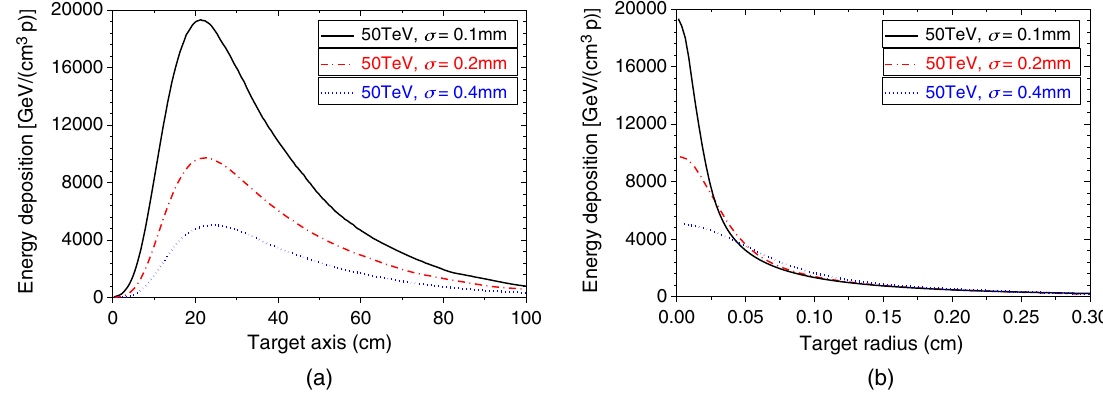
FIG. 4. Energy deposition per 50 TeV proton in a cylindrical copper target for three different beam sizes (a) in the longitudinal direction at r ¼ 0 and (b) in the radial direction at L ¼ 21 . 3 cm for the beam size of 0.1 mm, L ¼ 22 . 3 cm for 0.2 mm, and L ¼ 23 . 8 cm for 0.4 mm, where we have the maximum energy deposition.